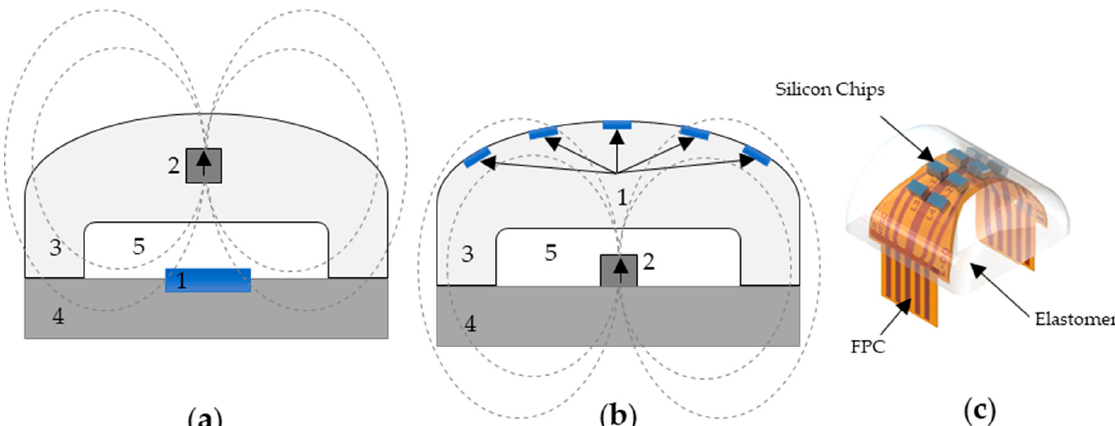
Figure 1. Schematic view of the devices’ working principle: ( a ) concept currently integrated in Vizzy hand [16]; ( b ) the flexible sensing matrix concept. The numbers in the figure stand for: 1—sensors (blue); 2—cylindrical Nd permanent magnet; 3—polymeric silicone part; 4—robotic finger; 5—air gap; ( - - - )—magnetic field lines for the permanent magnet. ( c ) 3D view of the FPC with the Si chips embedded in the elastomer part.